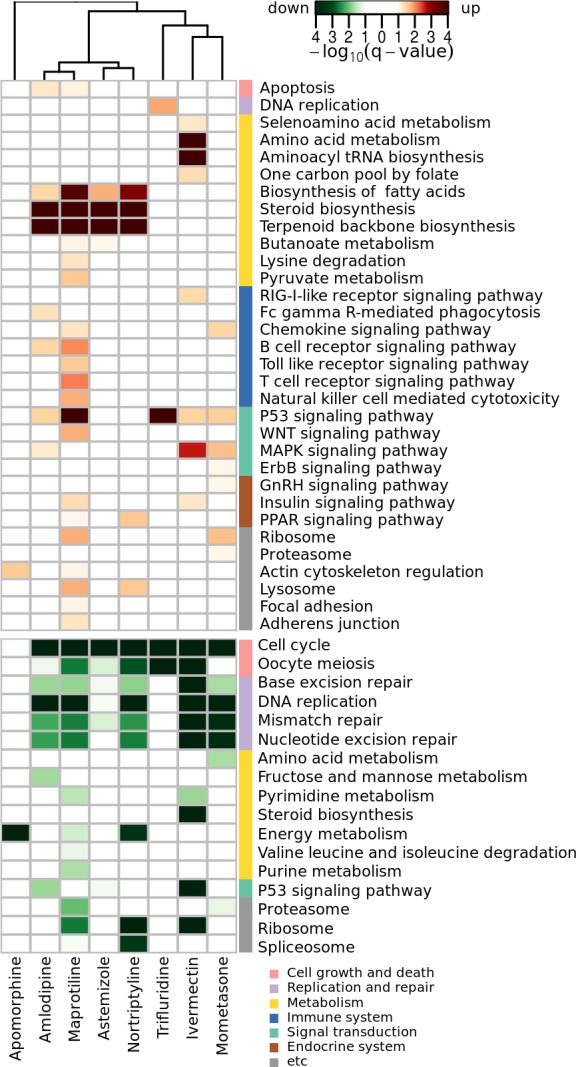
Pathway enrichment pattern of the eight active DR candidates for glioblastoma.The p-values and their adjusted q-values were calculated by hypergeometric test and the Benjamini-Hochberg method, respectively.